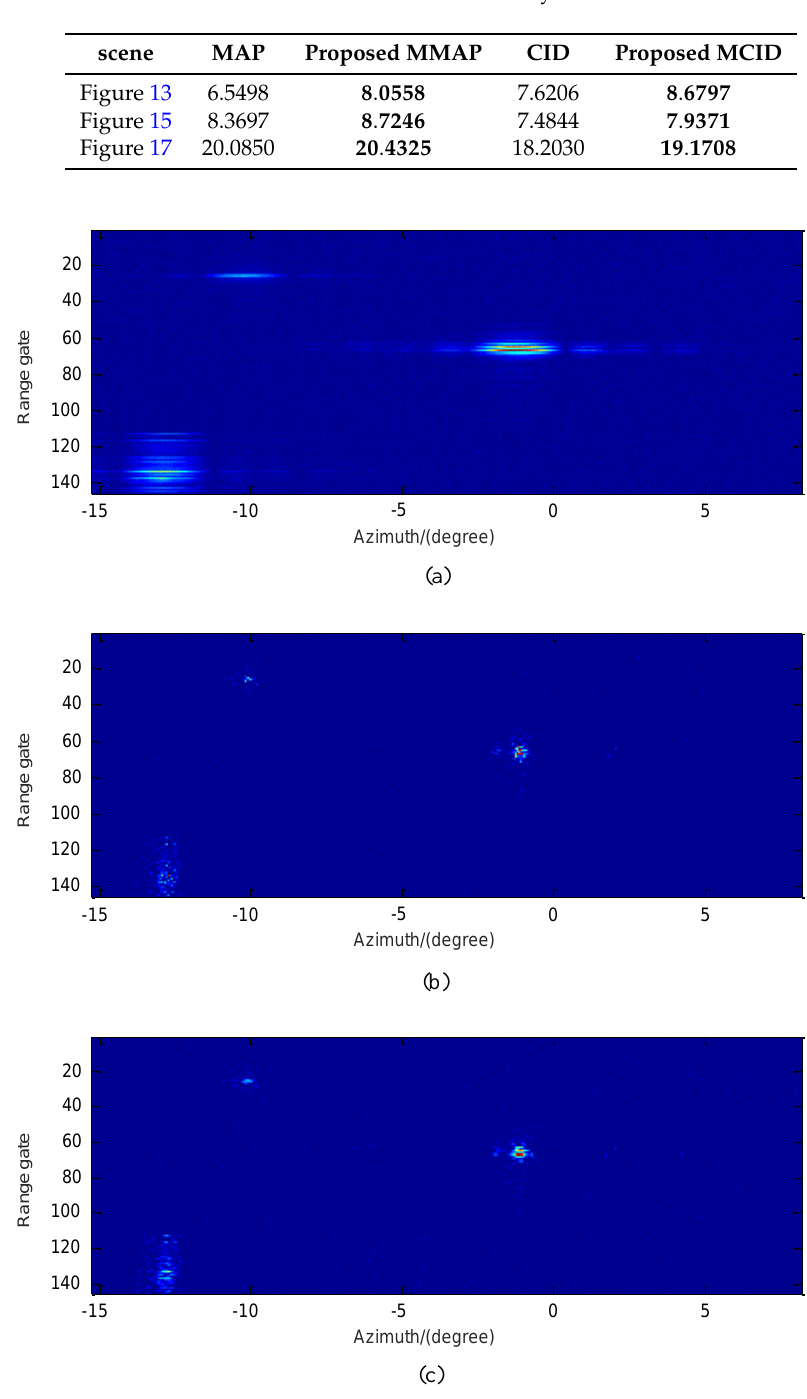
Figure 15. Imaging results of three targets by different methods. ( a ) Original real radar data; ( b ) Proposed MMAP; ( c ) Proposed